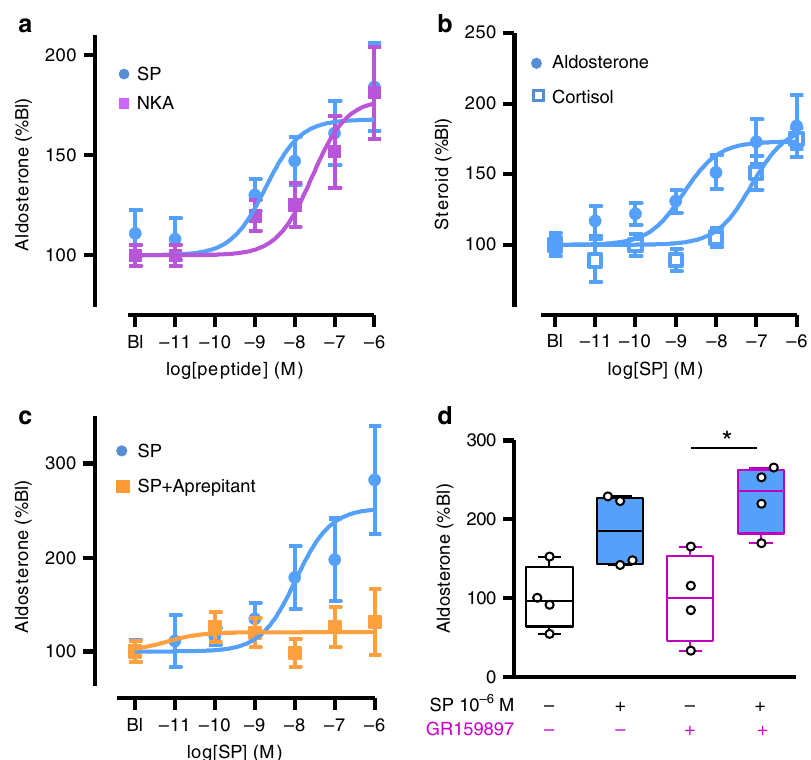
Fig. 3 Effect of tachykinins on steroidogenesis in cultured adrenocortical cells. a Effects of SP ( n = 23 independent cultures performed in quadruplicate) and neurokinin A (NKA; n = 5 independent cultures performed in quadruplicate) on aldosterone production. b Effect of SP on aldosterone and cortisol secretion ( n = 5 independent cultures performed in quadruplicate). c Effect of SP on aldosterone secretion in the absence or presence of the NK1R antagonist aprepitant (10 − 9 M; n = 7 independent cultures performed in quadruplicate). Dose-response curves were analysed by two-way ANOVA. Aprepitant inhibited the aldosterone response ( F = 10.14; DFn = 1; DFd = 72; p = 0.002). F distribution, DFn degrees of freedom for groups, DFd degrees of freedom for samples. Data are presented as mean ± SEM in panels a – c . d Effect of the NK2R antagonist GR159897 (10 − 9 M) on the aldosterone response to SP (10 − 6 M). Data are presented as median ± interquartile range (IQR), minima and maxima ( n = 4 cultures). They were analysed by two-tailed Mann – Whitney test. * p = 0.028. In all culture experiments, steroid secretion was normalised to basal level (Bl).